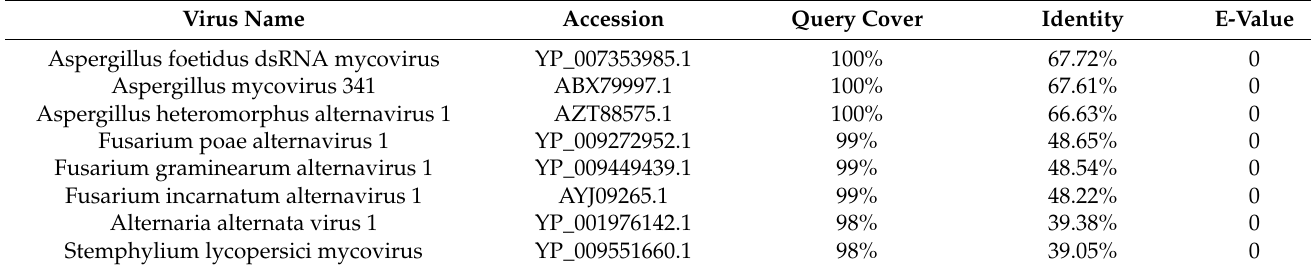
Table 1. Identity between FoAV1 ORF1-encoded protein (RdRp) and equivalent proteins of other proposed alternaviruses.